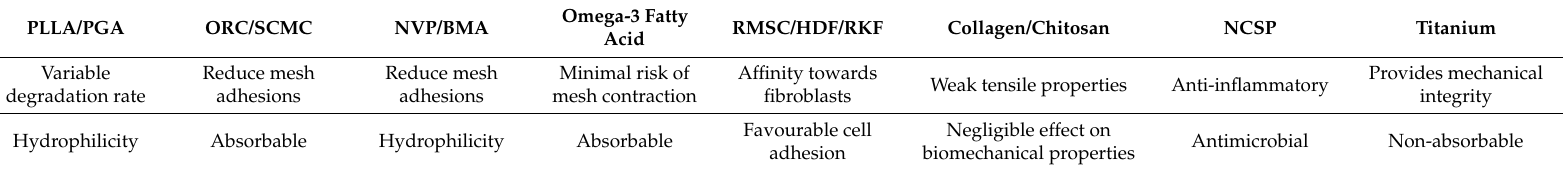
Table 5. Material properties of surgical mesh